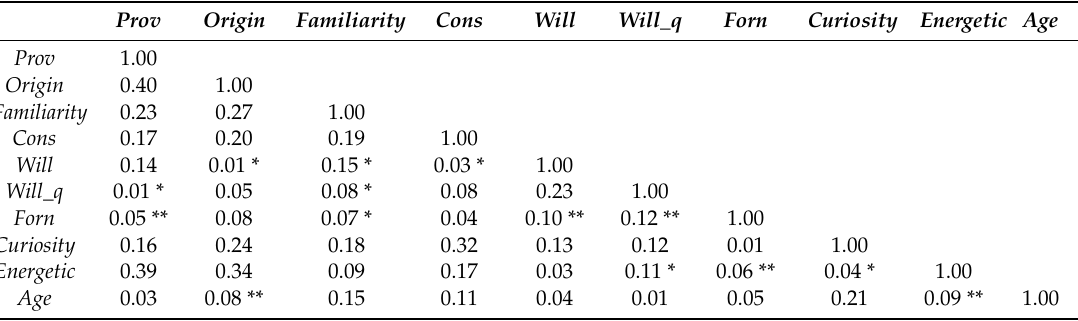
Table 6. Pearson correlations between explanatory variables of the full multilevel logistic regression model.